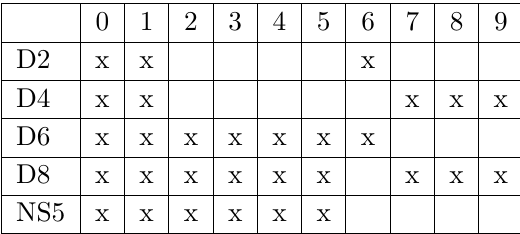
Table 1 . 1 -BPS brane intersection underlying the AdS 3 solutions. ( x 0 ; x 1 ) are the directions where 8 the 2d CFT lives, ( x 2 ; : : : ; x 5 ) span the CY 2 , on which the D6, the D8 and the NS5 branes are wrapped, x 6 is the direction along the (cid:26) -interval, and ( x 7 ; x 8 ; x 9 ) are the transverse directions on which the SO(3) R symmetry is realised.